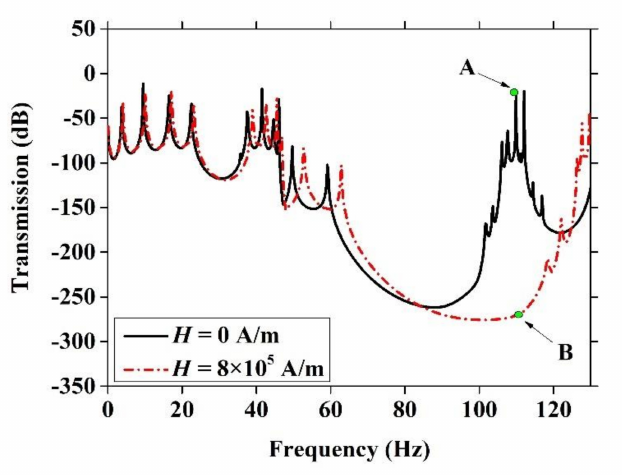
Figure 18. The transmission response curves with di ff erent magnetic field intensity H